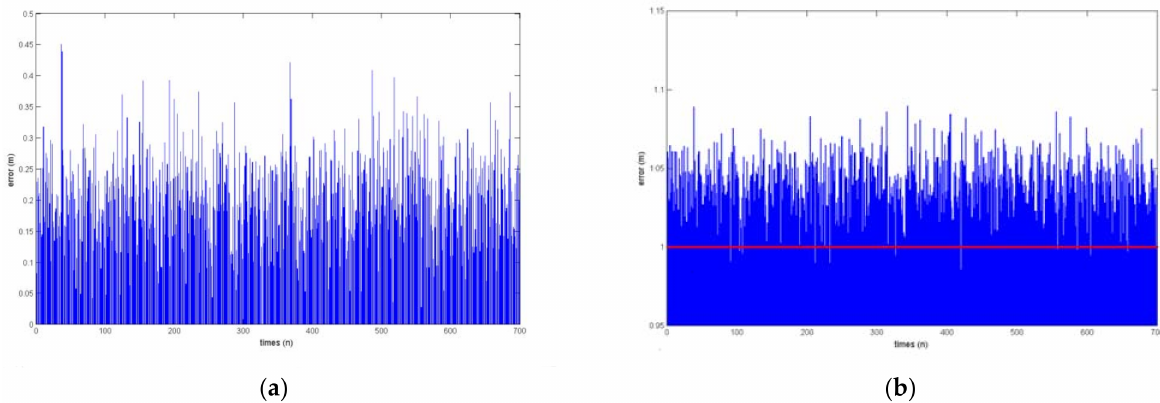
Figure 16. ( a ) Position and ( b ) velocity deviation results with 10% noise in the